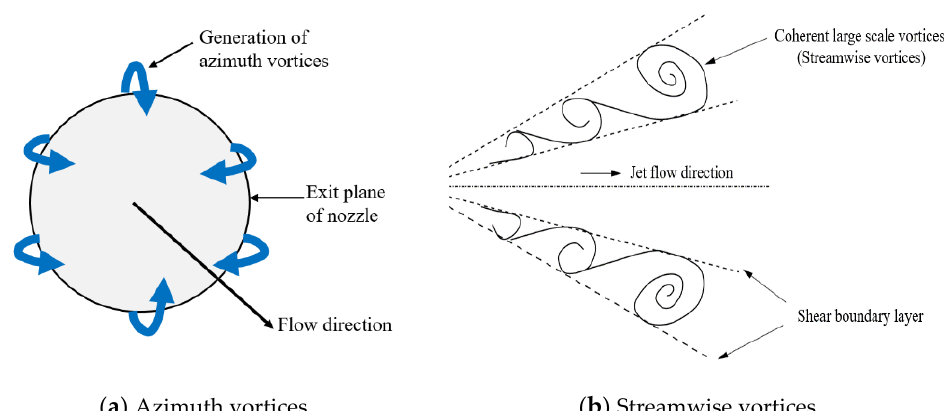
Figure 2. Generation of vortices at different planes